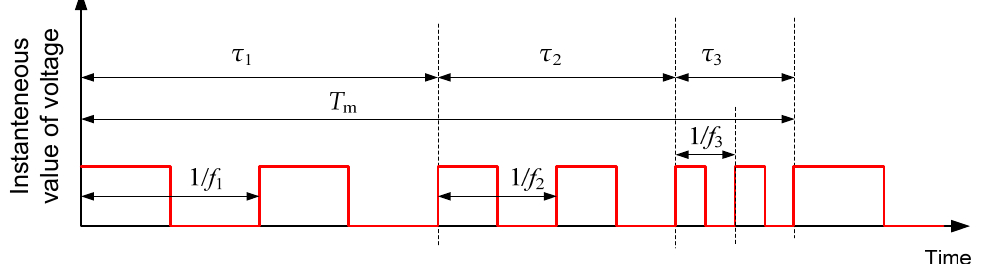
Figure 1. Waveform of a square signal with classical 3-switching frequency technique. In this figure, N 1 = N 2 = N 3 ; τ 1 ≠ τ 2 ≠ τ 3 ; frequency order is from low to high.